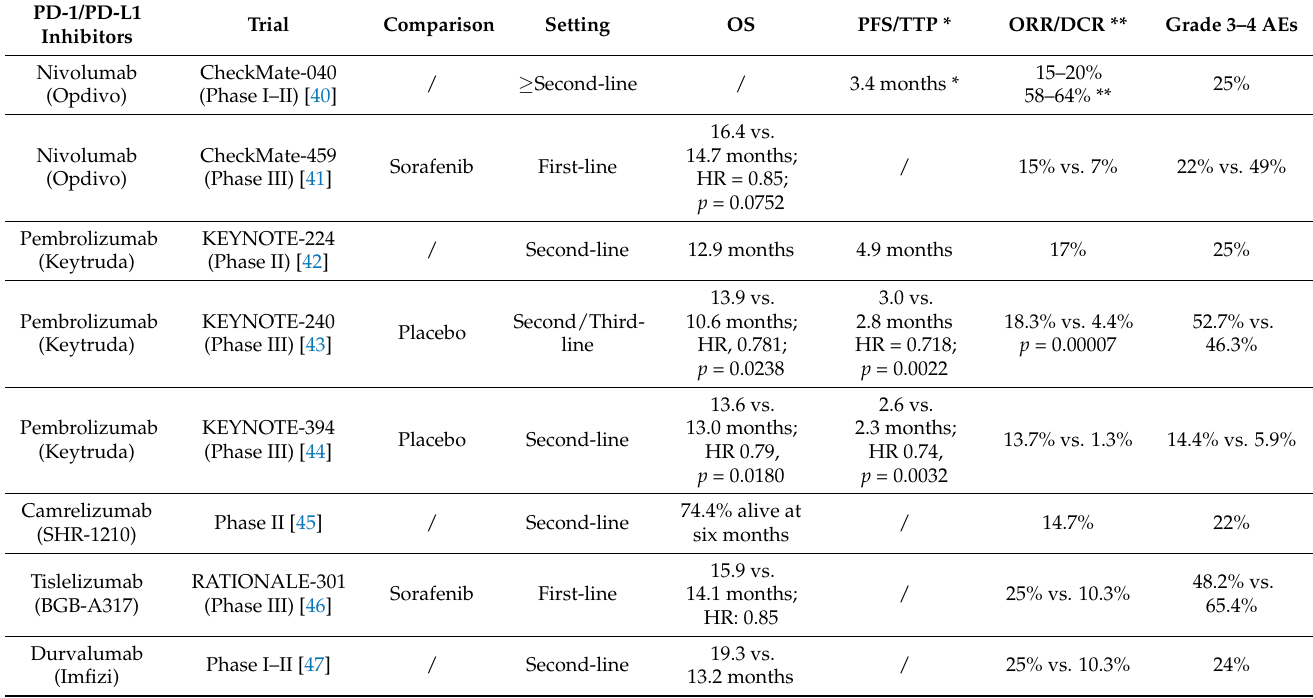
Table 1. PD-L1 inhibitors as single agents for the treatment of advanced